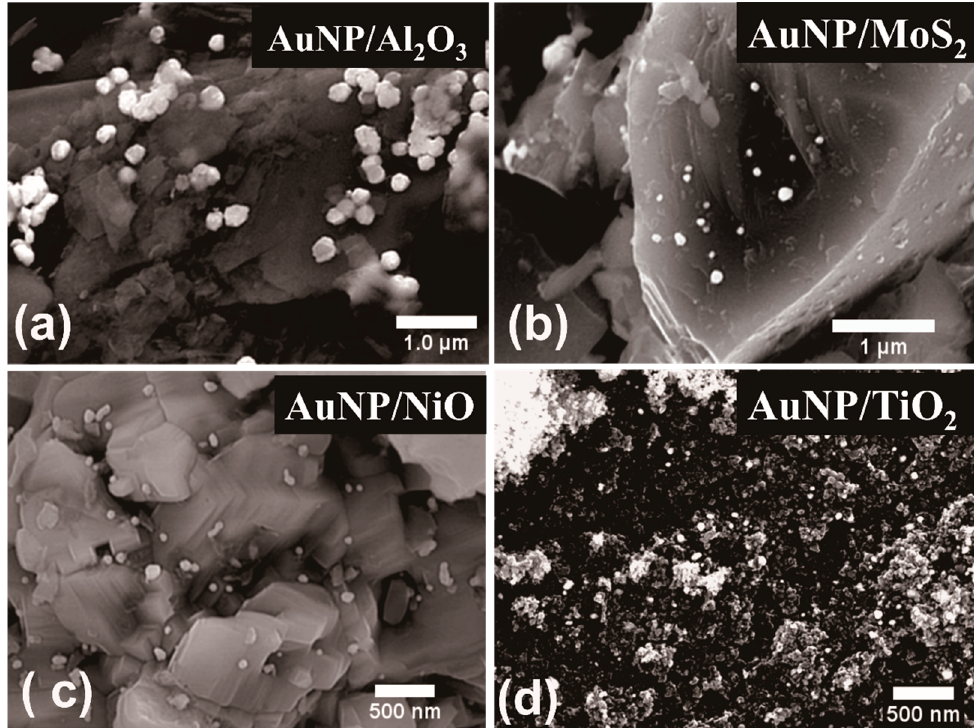
Figure 3. SEM images from gold nanoparticles (AuNPs) supported onto various substrates using the chemical impregnation synthesis route. The selected supports are ( a ) Al 2 O 3 , ( b ) MoS 2 , ( c ) NiO, and ( d ) TiO 2 , respectively. EDS from these supported AuNPs and AuNPs on other supports are shown in the Electronic Supplementary Information (Figures S1 and S3).